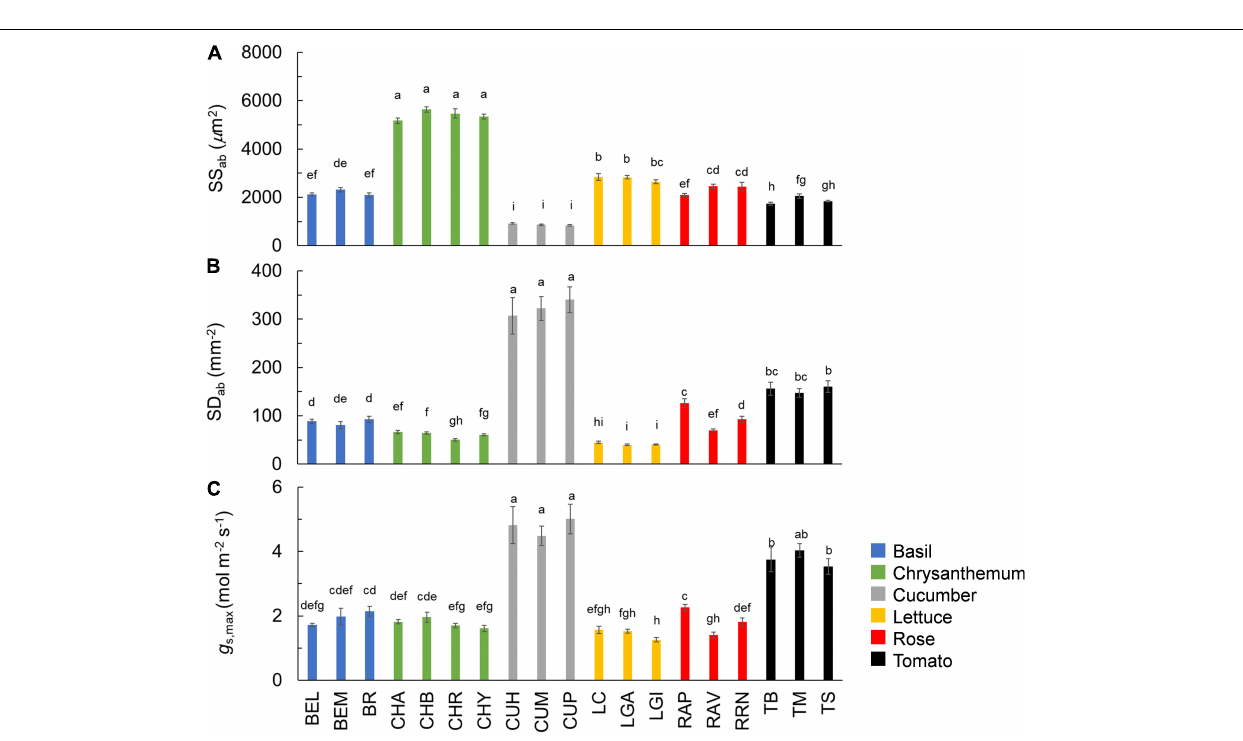
FIGURE 4 | Time constants describing the fast ( A: τ fast ) and slow ( B: τ slow ) phase of V cmax kinetics during photosynthetic induction. Colors indicate crop species. Bars show means ± SE ( n = 6–7). Letters indicate significant differences ( p < 0.05). Refer to Table 1 for full genotype names.